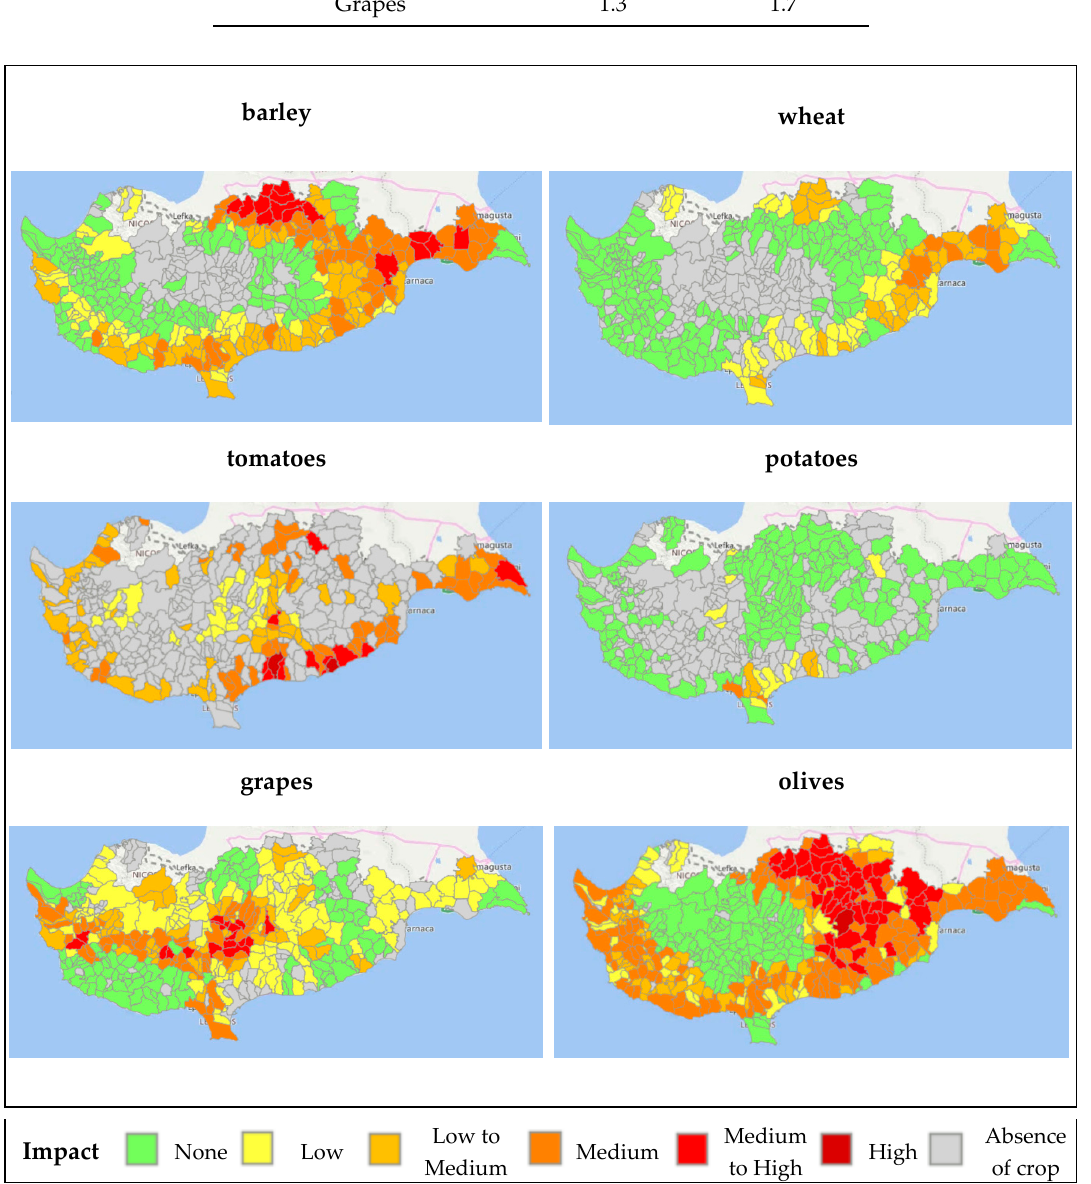
Figure 1 . Estimated total climate change impacts on the agricultural sector of Cyprus (RCP4.5). Figure 1. Estimated total climate change impacts on the agricultural sector of Cyprus